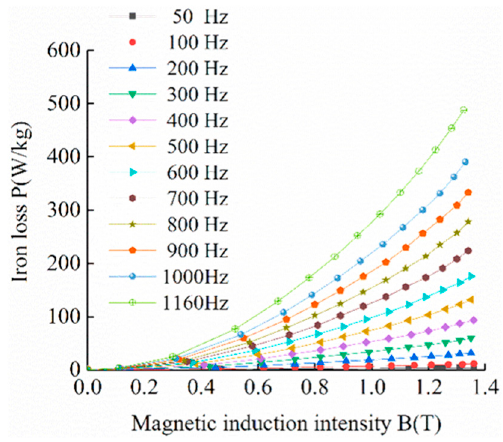
Figure 3. BH curves of 50W310 silicon-steel sheet at different temperatures.